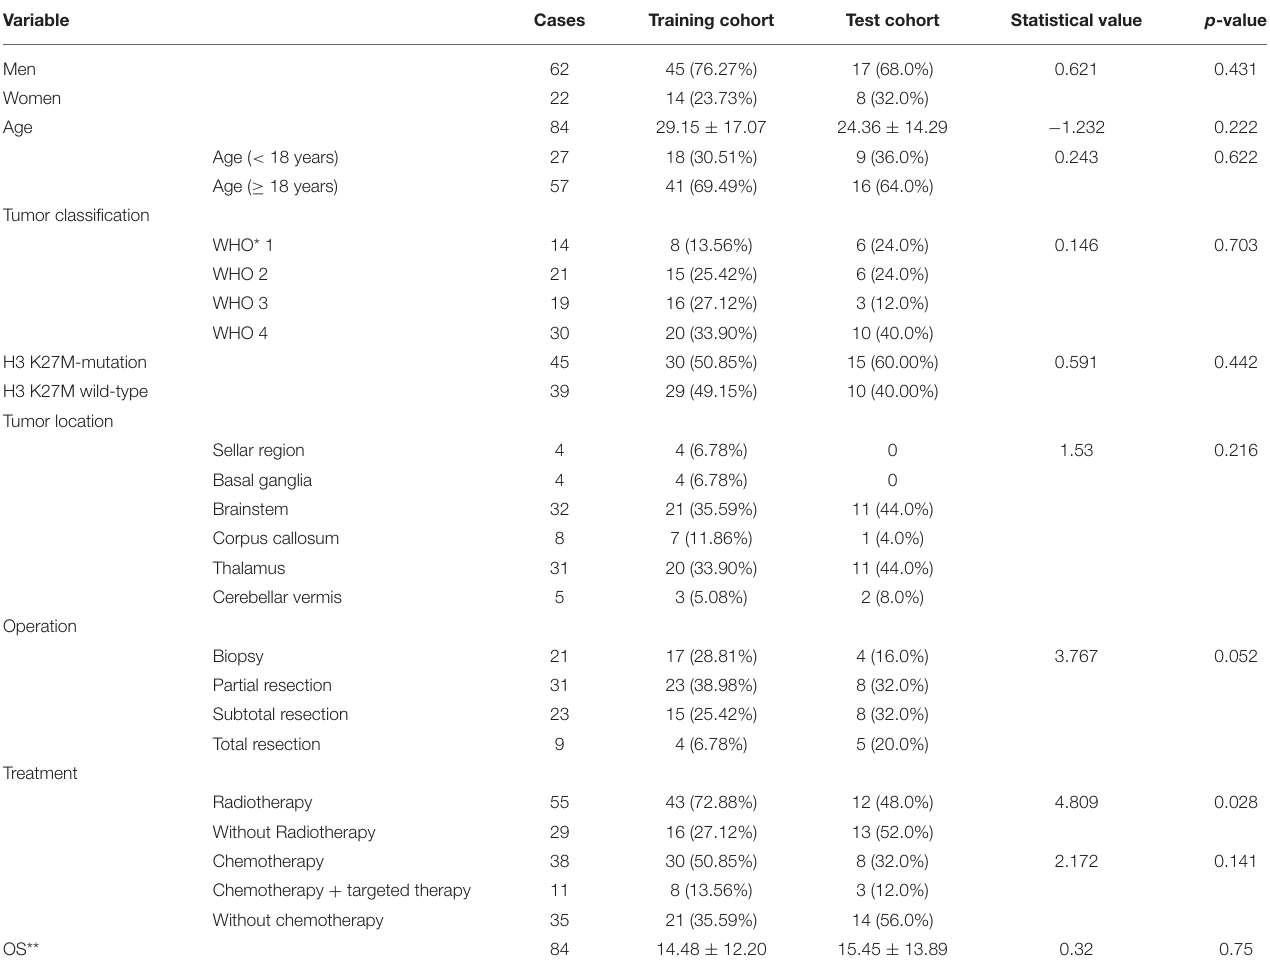
TABLE 2 | Clinical characteristics of 84 patients in the training and test cohorts.